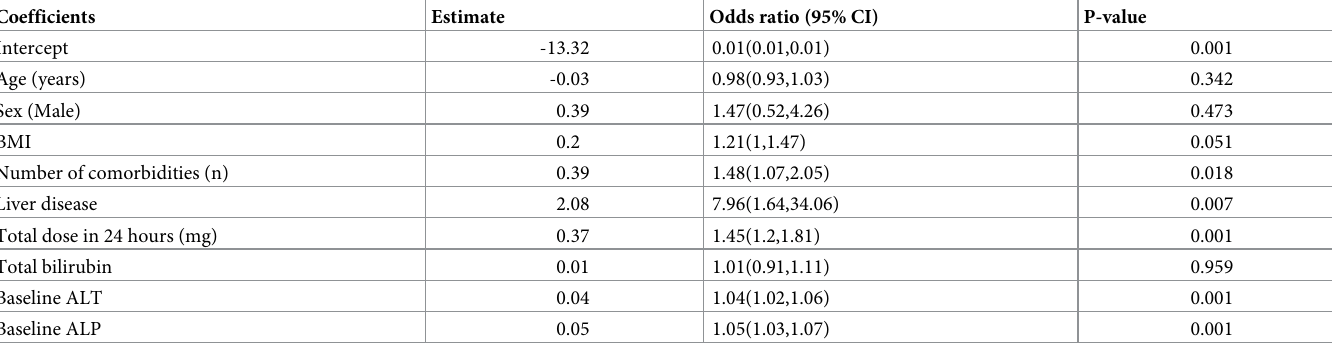
Table 4. Model 1: Multiple logistic-regression results relating the factors of drug-induced liver injury.